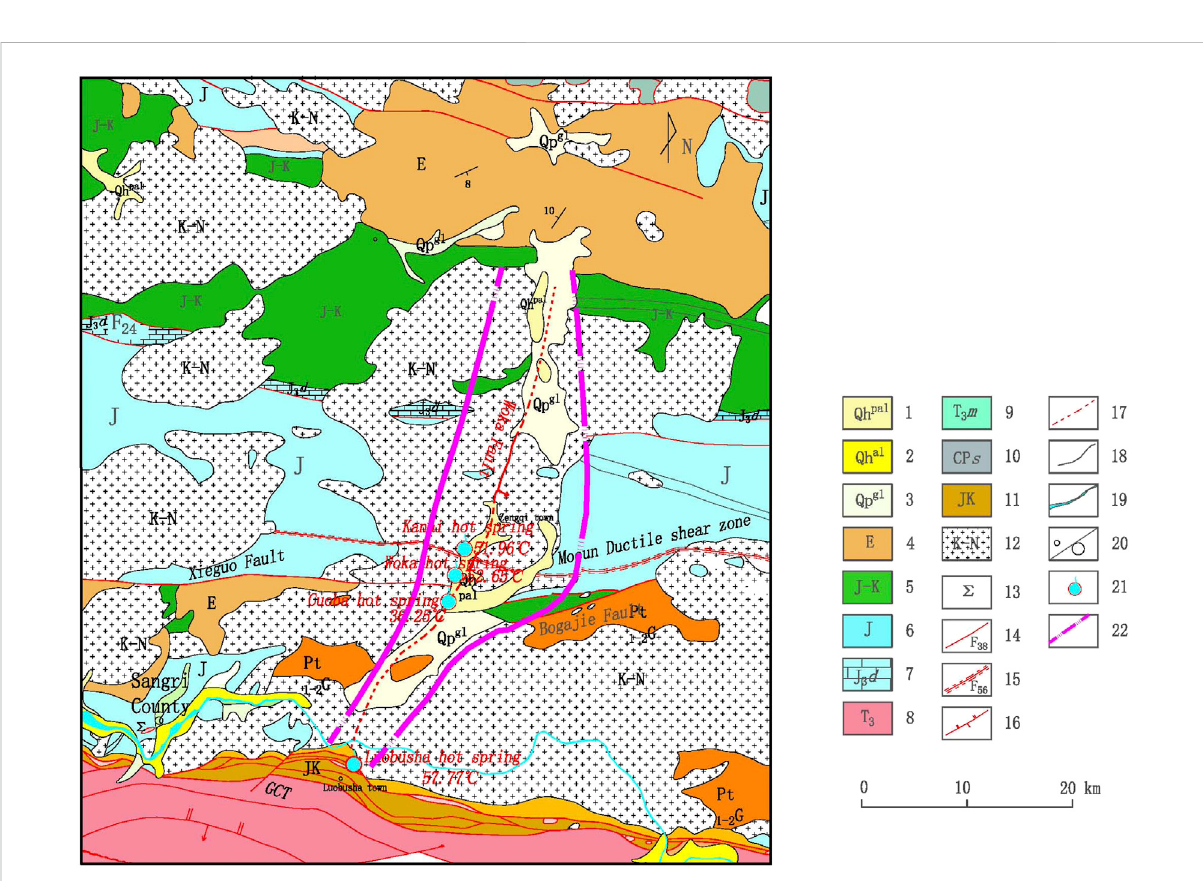
FIGURE 1 Geological background map of Oiga Graben basin. 1-Holocene alluvial deposits; 2-Holocene alluvium; 3-Pleistocene glacial deposits; 4- Paleogene volcanic rocks; 5-Late Jurassic Cretaceous and Cretaceous; 6-Sedimentary assemblage of Jurassic volcanic and continental clastic rocks; 7-Duodigou formation limestone; 8-Late Triassic Century; 9-Mailonggang formation; 10-Songduo group; 11-Jurassic-Cretaceous melange; 12-Cretaceous-Neogene intrusive rocks; 13-Ultrabasic block; 14-Fault and number; 15-Ductile shear zone and number; 16-Reverse fault; 17- Inferred fault; 18-Geological boundary; 19-River system; 20-Town/City; 21-Hot spring; 22-Range of fault graben